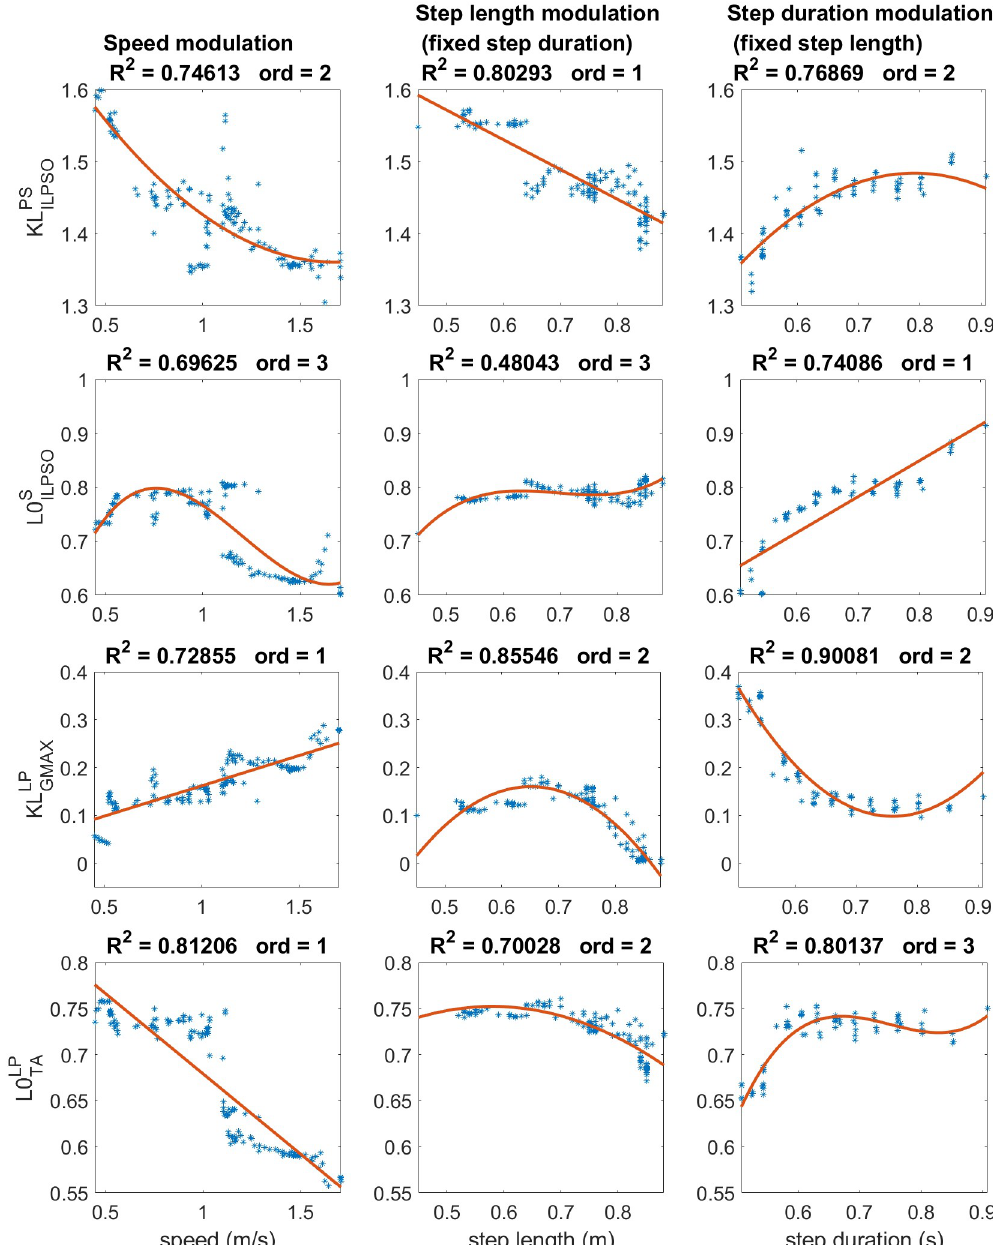
Fig 3. Regression analysis of step length and step duration modulators with effects on speed. The stretch reflex gain of iliopsoas during pre-swing and the length offset during swing have a decreasing impact on speed due to decreasing step length and increasing step duration for the former and primarily for step duration increasing for the latter. On the other hand, the stretch reflex gain of gluteus maximus in landing preparation has an increasing linear effect on the speed with nonlinear effects on step length and step duration. The length offset of tibialis anterior’s stretch reflex can modulate fast speed with large step lengths and short step durations but has less effect in the modulation of slow gaits. relation roughly constant with a minimal effect on speed. Both these parameters are related to the hamstring’s stretch reflex activity during landing preparation and are represented by the gain and the length offset. From the graphs at the top of Fig 4, the gain decreases accordingly with both step length and step duration resulting in a null effect on the speed modulation as